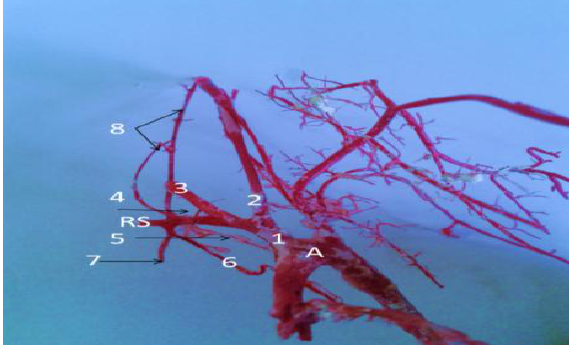
Figure, 4:The cast of the aortic arch in rabbits (right lateral view)showing branches of Brachiocephalic trunk (A)aortic arch (RS) Right subclavian artery (1) brachiocephalic trunk (2) left common carotid artery (3) Right common carotid artery (4) Cervical profund artery (5) Costocervical artery (6) intrnal thoracic artery (7) external thoracic artery (8) Vertebral arteries.